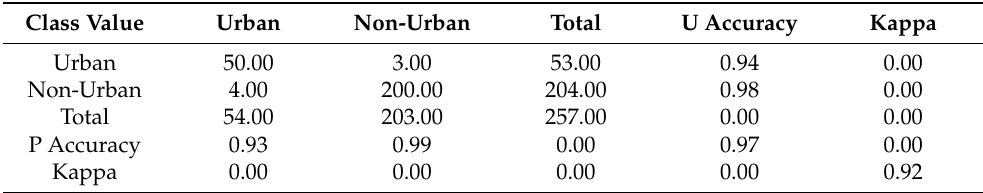
Table 4. Kappa results for land use classification,